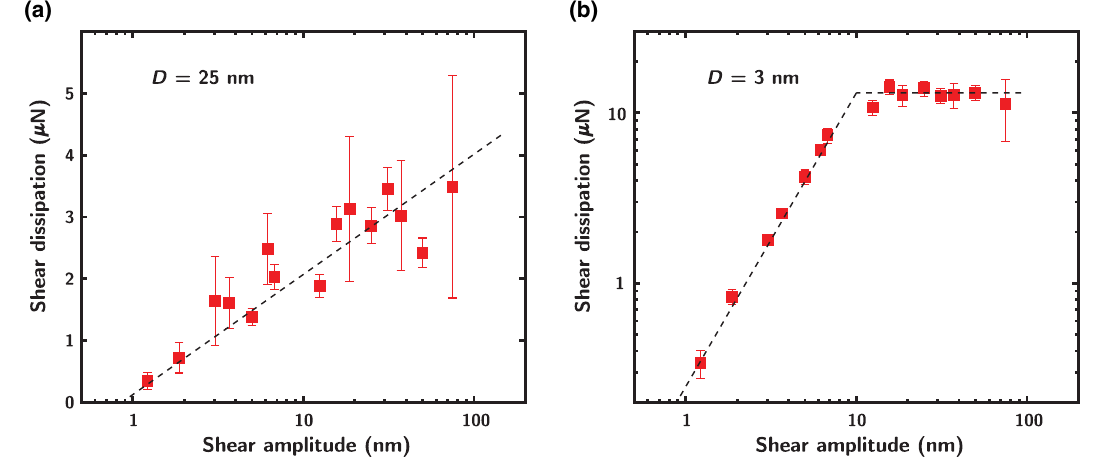
FIG. 4. Shear frictional properties of the solid interfacial phase. (a) Logarithmic dependence of the dissipative friction force with respect to the shear amplitude for a fixed confinement distance D ¼ 25 nm. (b) Transition from a power-law to solid friction for fixed separation distance D ¼ 3 nm. Error bars represent the standard error and correspond to 10% for single